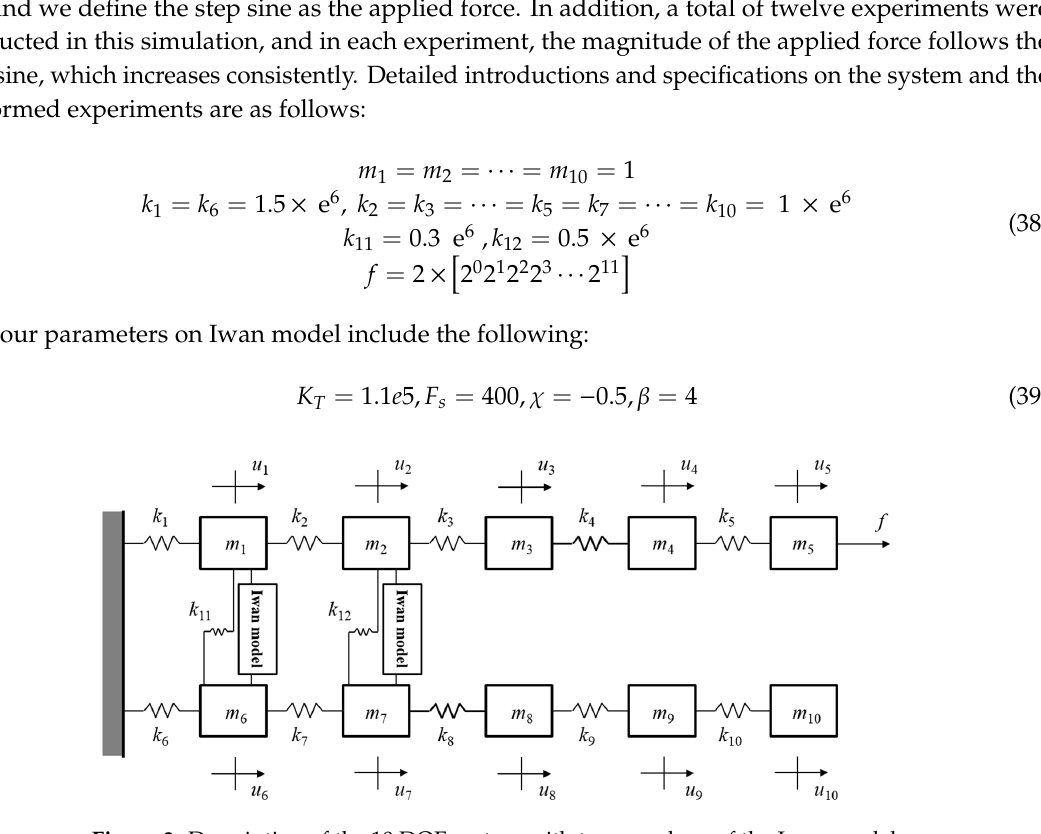
Figure 3. Description of the 10 DOF system with two numbers of the Iwan model.